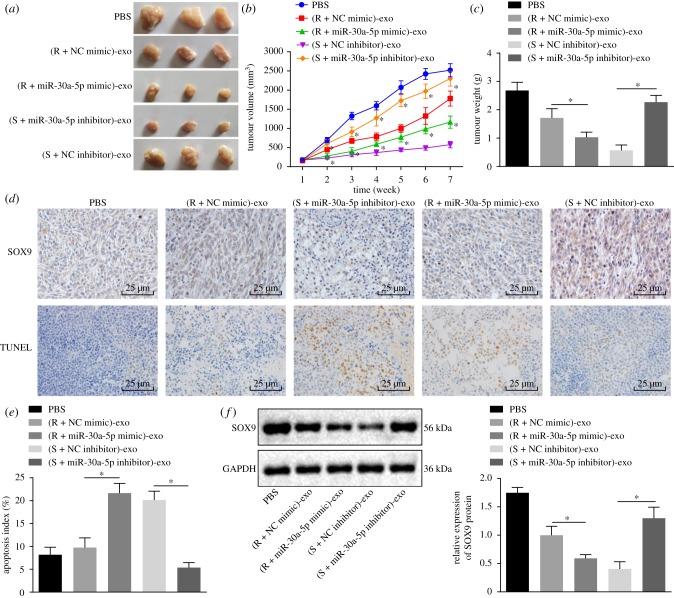
Exosomes carrying miR-30a-5p inhibit tumour growth and promote apoptosis of tumour cells in nude mice. (a) Representative images of subcutaneous tumours in nude mice. (b) Tumour volume growth curves after multiple injections of exosomes. (c) Tumour weight after multiple injections of exosomes. (d) Immunohistochemical staining of SOX9 protein expression in tumours in the top; representative images of TUNEL positive cells in the bottom. Scale bar = 25 µm. (e) Apoptosis detected by TUNEL assay. (f) Protein expression of SOX9 normalized to GAPDH measured by western blot analysis. *p < 0.05 versus PBS. R + NC mimic referred to SKOV3/DDP transfected with NC mimic; R + miR-30a mimic referred to SKOV3/DDP transfected with miR-30a mimic; S + NC inhibitor referred to SKOV3 transfected with NC inhibitor; S + miR-30a inhibitor referred to SKOV3 transfected with miR-30a inhibitor; S, sensitive; R, resistant. Exosomes derived from those cells were injected into nude mice. Measurement data were expressed as mean ± standard deviation. Comparison between two groups was analysed by unpaired t-test. Comparisons among multiple groups were conducted by one-way ANOVA with Tukey's post hoc test. Data at different time points were compared by repeated-measures ANOVA, followed by Bonferroni post hoc test (n = 10).